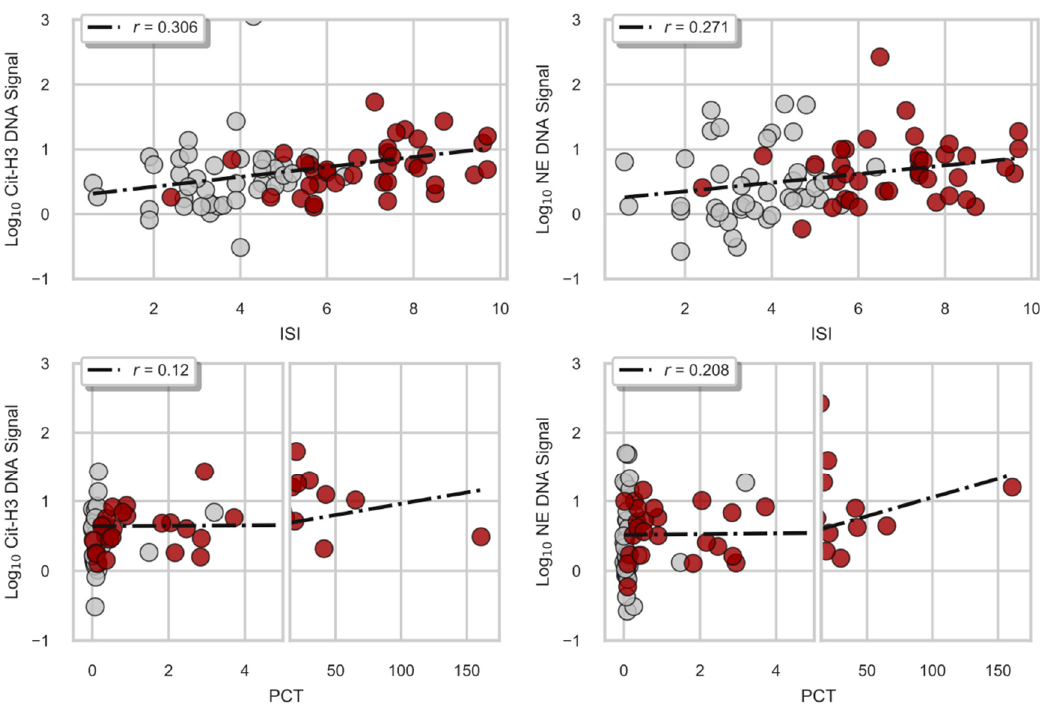
Figure 5. Correlation between neutrophil extracellular trap (NET) quantities, measured through citrullinated histone H3 (Cit-H3) DNA and neutrophil elastase (NE) DNA, and IntelliSep Index (ISI) or procalcitonin (PCT). “r” values indicate Pearson correlation coefficients. ISI yielded higher correlation coefficients with Cit-H3 DNA and NE DNA signals than PCT. Gray and maroon markers indicate Control and Diseased patients, respectively.